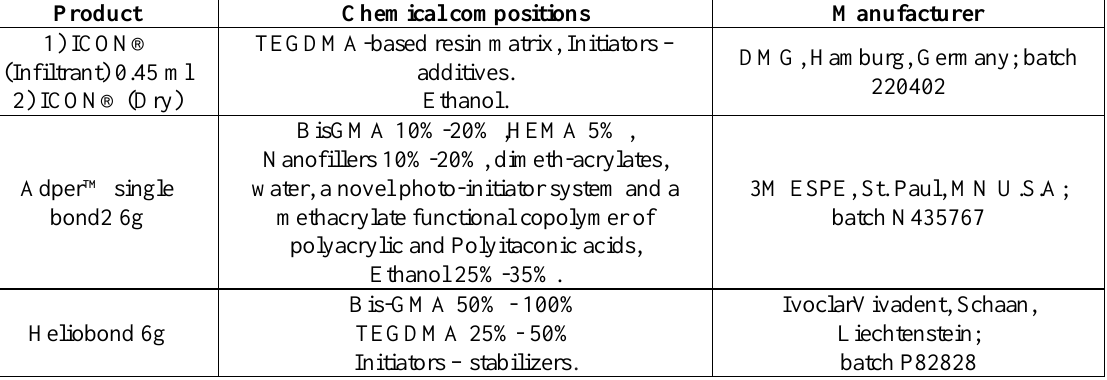
Table 1: Composition of the low-Viscosity caries Infiltrant and the conventional bonding resins according to the manufacturers’